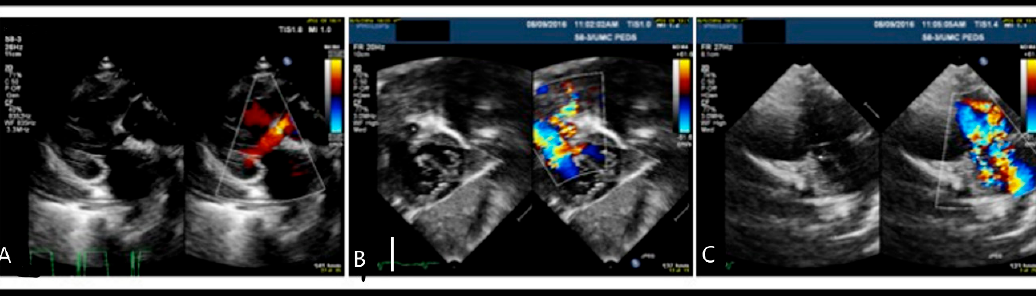
Figure 2. Echocardiogram: ( A ) Long axis view of ventricular septal defect (VSD) demonstrating pulmonary vessel stenosis. ( B ) Subcostal four chamber view of VSD with aorta overriding pulmonary artery and feeding into right ventricle. ( C ) View of double outlet pulmonary artery and aorta from right ventricle with VSD present.